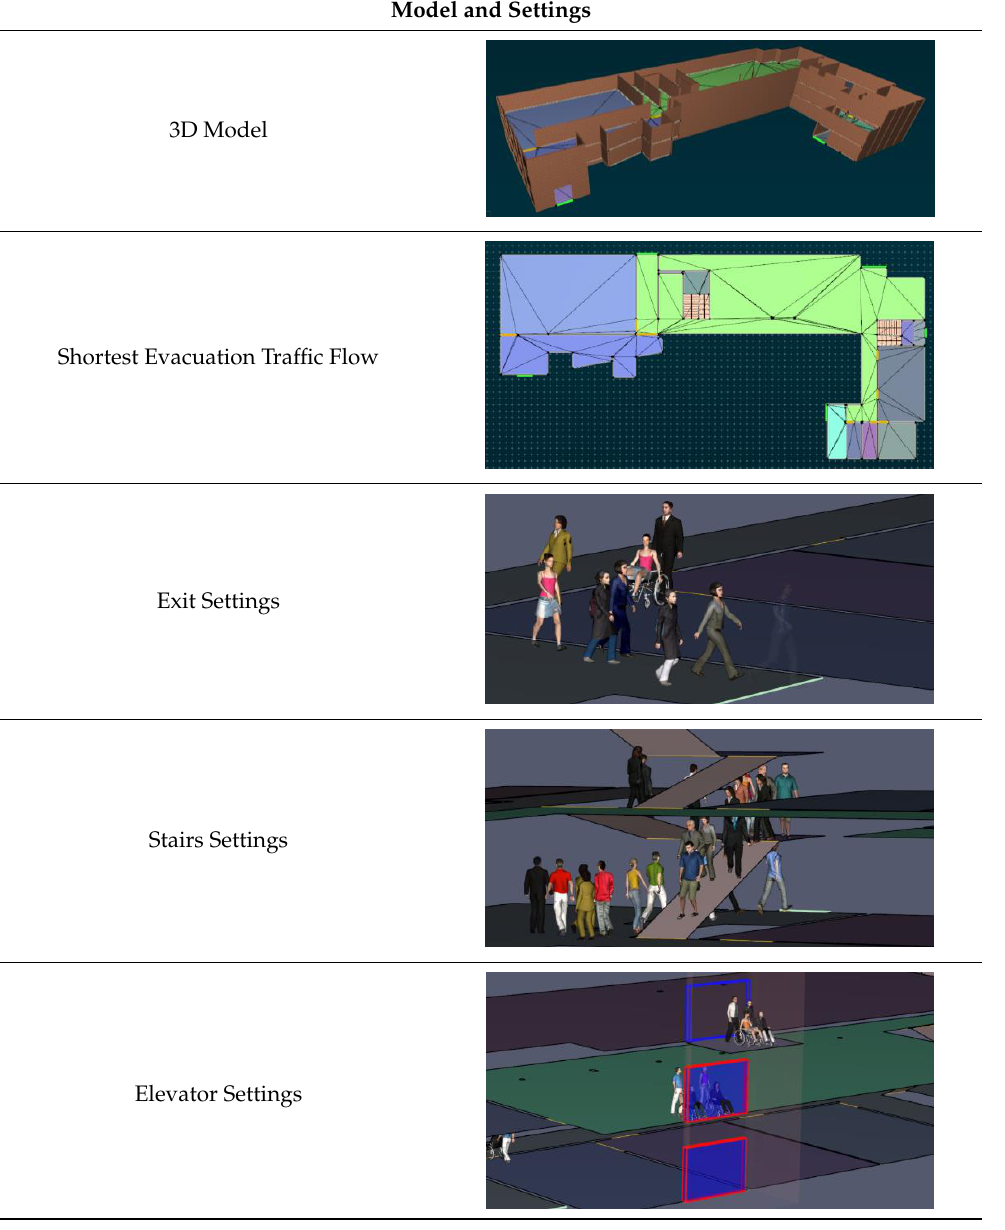
Table 3. Fire hazard indicators for human tolerance (organized in this study). Hazard